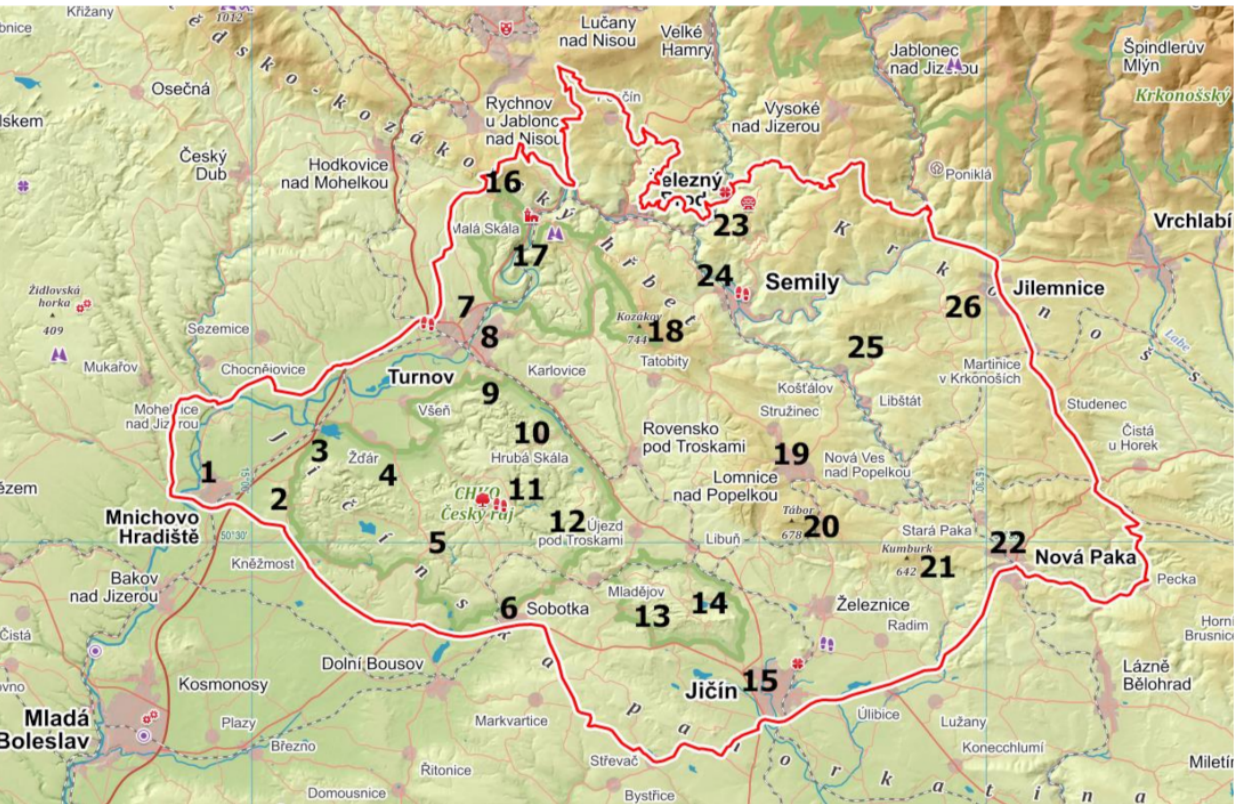
Figure 4. Location of data collection points within the Bohemian Paradise UNESCO Global Geopark. Description: 1— Mnichovo Hradištˇe, 2—Valeˇcov, 3—Kr á sn á vyhl í dka, 4—Pˇr í hrazy, 5—Kost, 6—Sobotka, 7—Hrub ý Rohozec, 8—Turnov, 9—Valdštejn, 10—Hrub á Sk á la, 11—Neb á kov, 12—Trosky, 13—Prachovsk é sk á ly, 14—Jinonice, 15—Jiˇc í n, 16—Fr ý dštejn, 17— Mal á Sk á la, 18—Koz á kov, 19—Lomnice, 20—T á bor, 21—Kumburk, 22—Nov á Paka, 23—Bozkov, 24—Semily, 25—Košt’ á lov,